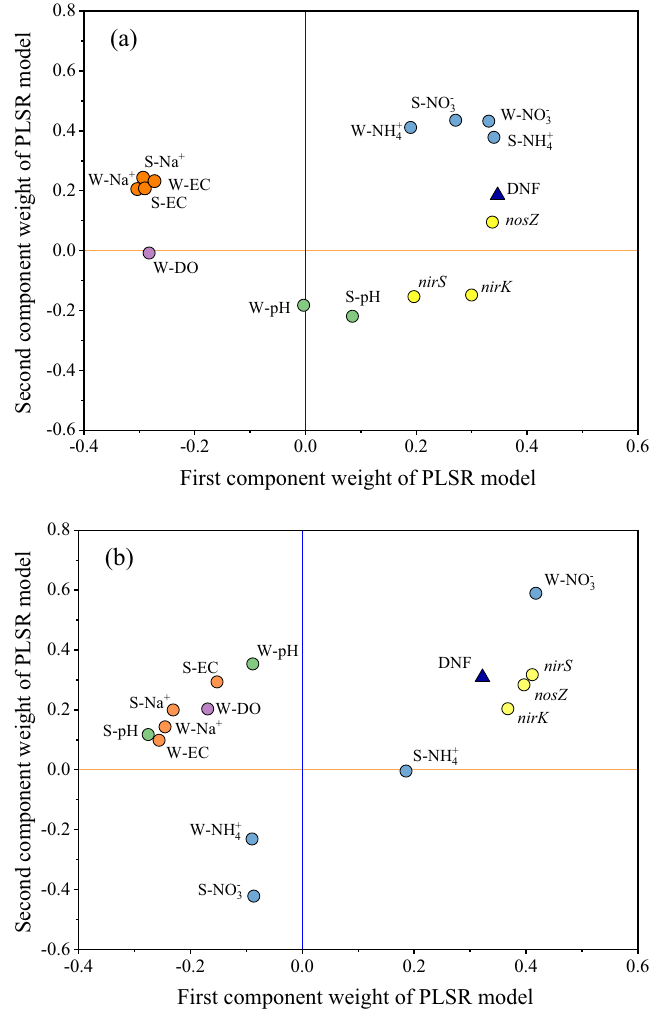
Figure 5. Weight plots of the first and second PLSR components for denitrification rates ( a , saline environment; b , saline-alkali environment). DNF indicates the denitrification rate. “W-” and “S-” indicate the overlying water and sediment,